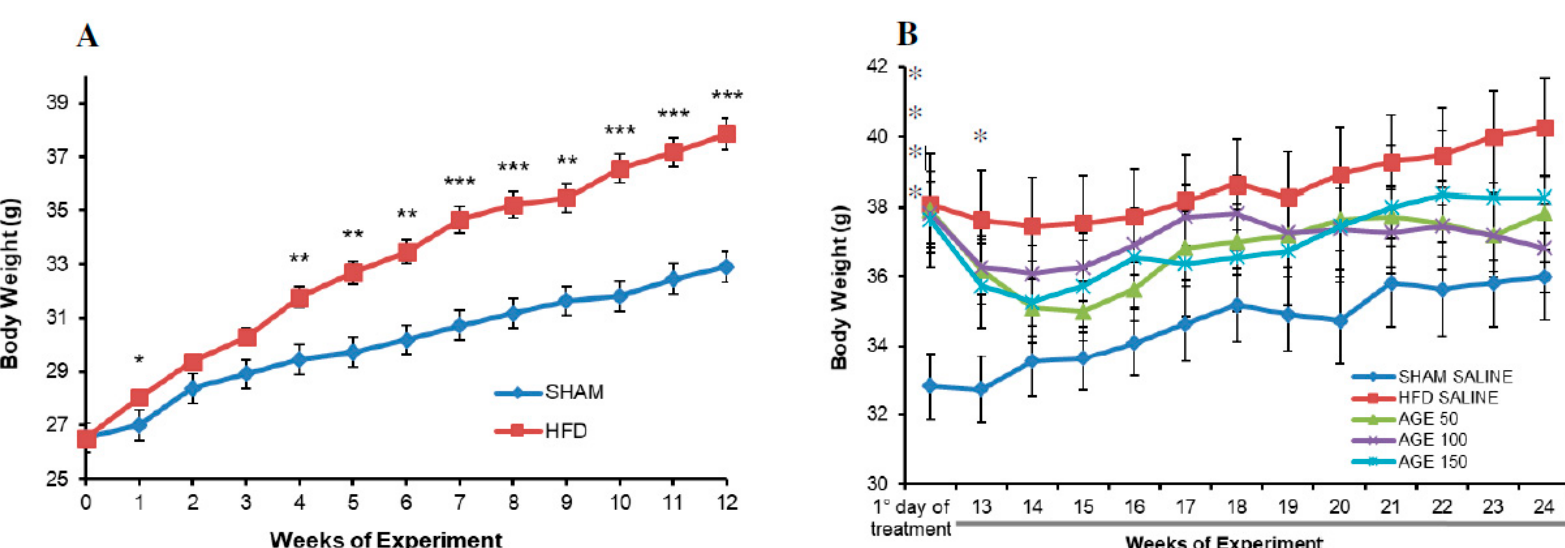
Figure 1. E ff ects of a hyperlipidic diet and AGE on weight gain. ( A ) Body weight of animals fed on the standard diet (SHAM) and on the hyperlipidic diet (HFD) during obesity induction for 12 consecutive weeks (0: initial weight). ( B ) Weight of control animals (SHAM SALINE: standard diet + saline solution. HDF SALINE: hyperlipidic diet + saline solution) and of animals treated with aqueous graviola leaf extract (AGE) (AGE 50: hyperlipidic diet + 50 mg / kg AGE. AGE 100: hyperlipidic diet + 100 mg / kg AGE. AGE 150: hyperlipidic diet + 150 mg / kg AGE) (depicted on the graph from the first day of treatment up to the 24th week). Values represent mean ± mean standard error. * p ≤ 0.05, ** p ≤ 0.01 and *** p ≤ 0.001 vs. SHAM SALINE. Student t-test (Figure 1A) and ANOVA followed by post Tukey test (Figure 1B).